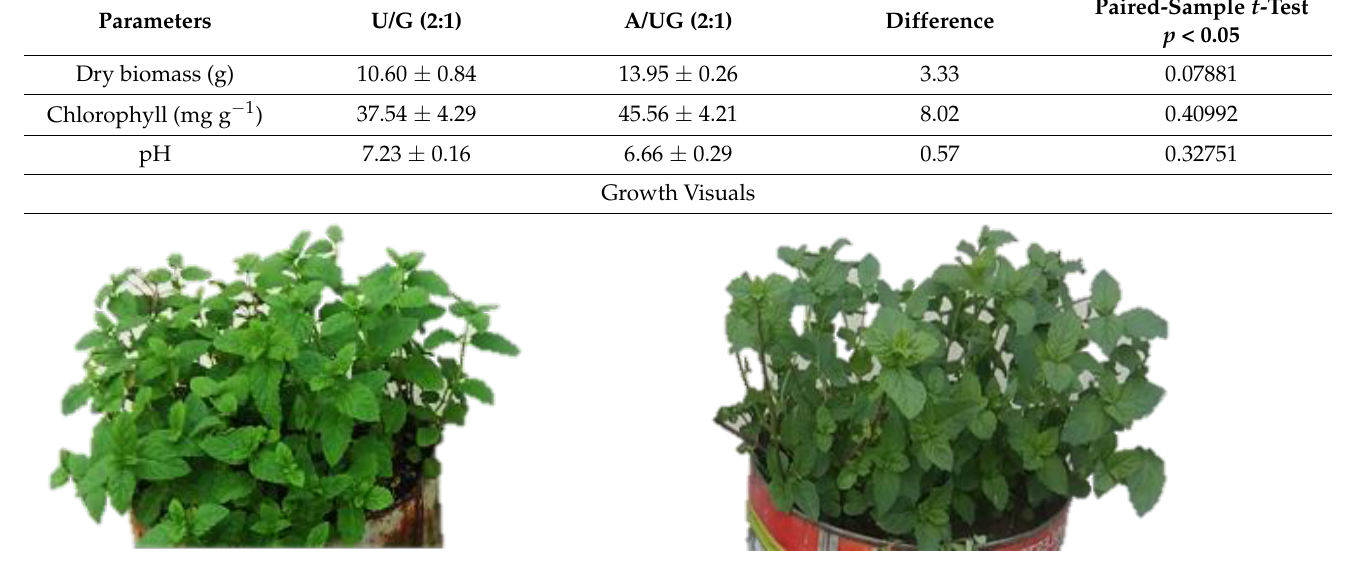
Table 4. The comparison of wood ash added urea gelatin film effect on growth performance of M. spicata plant and soil quality.